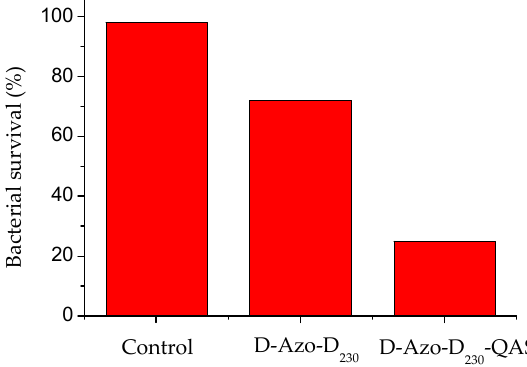
Figure 10. Antimicrobial activity of hydrogels tested against E. coli